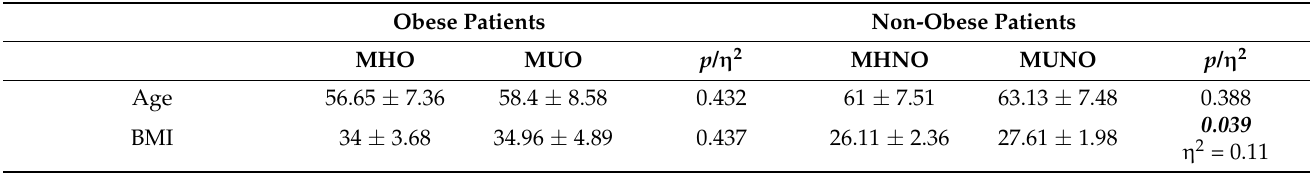
Table 2. Clinical and biochemical characteristics of obesity phenotypes. Obese